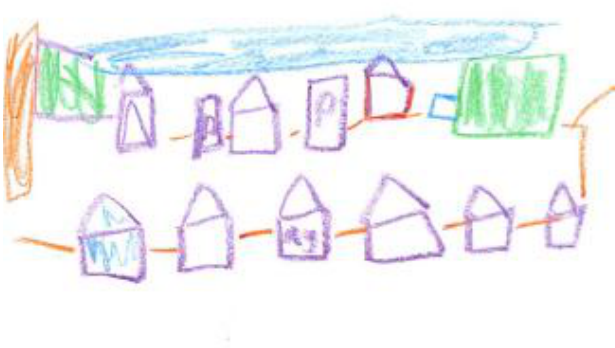
Figure 2. Gabby’s Neighborhood and the